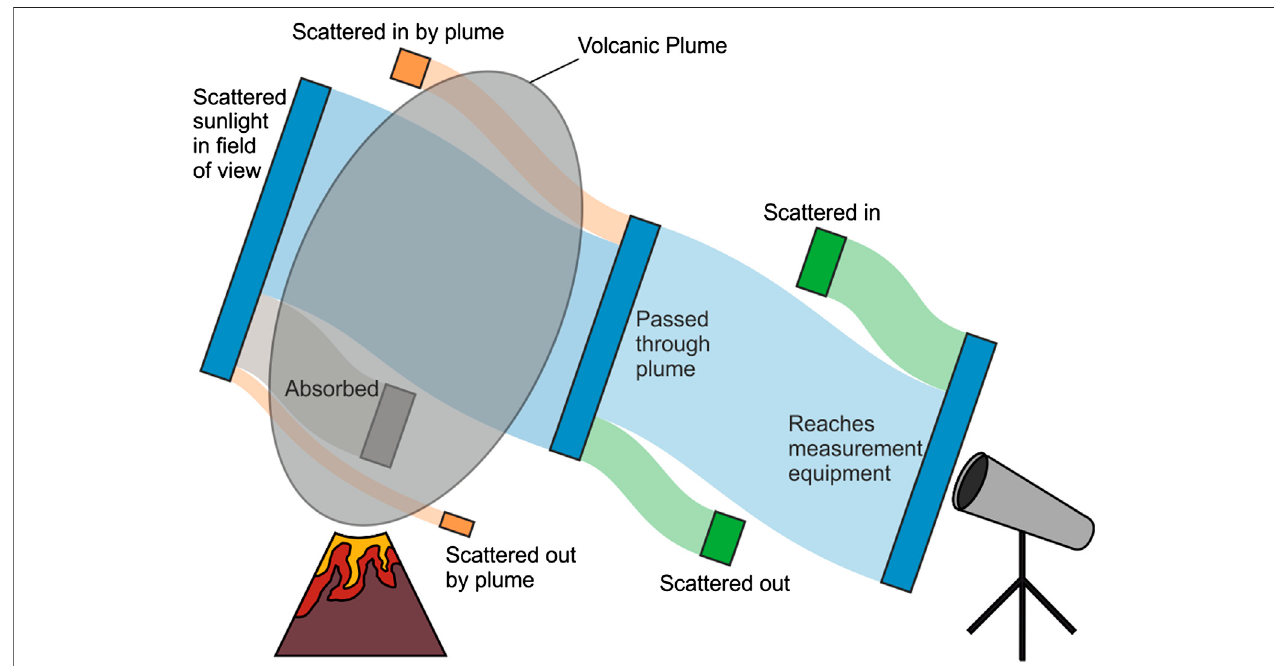
FIGURE 1 | Scattered sunlight (blue) in the fi eld of view of the instrument does not all arrive at the measuring device. Gases in the plume (gray) absorb some of the light.Radiative transfer effects intheplume such assingle andmultiple scattering byaerosols (orange)alsoaffecthowmuch lightreachestheotherside. Onceoutofthe plume, photons can be scattered by ambient aerosols and molecules between the plume and the equipment, causing the light dilution effect (green). In general, the impact of light dilution is greater when the distance and opacity of the plume is greater.